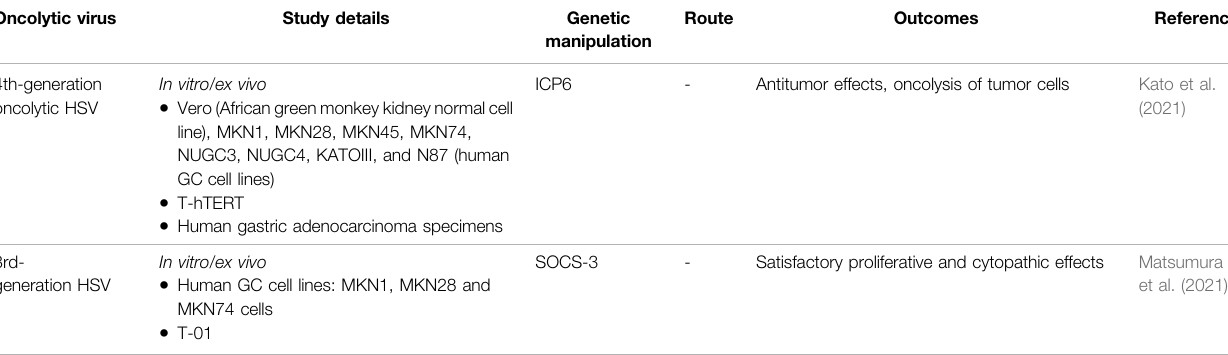
TABLE 2 | ( Continued ) Oncolytic viruses used in the treatment of PMGC.